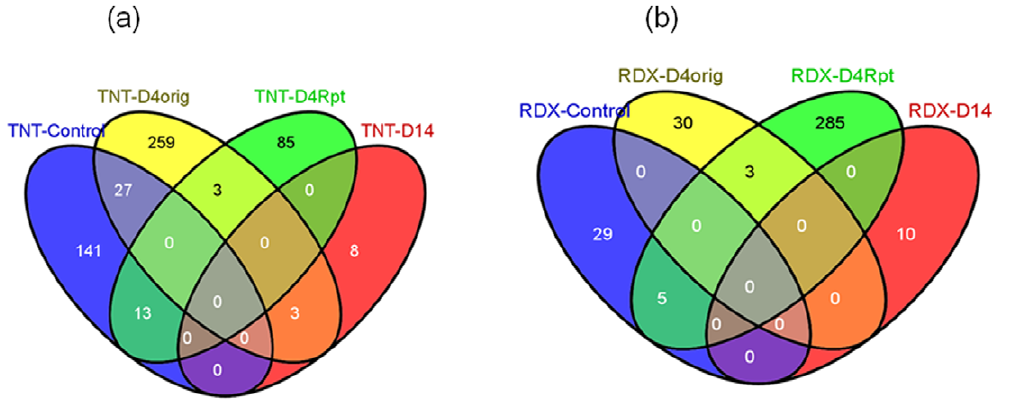
Figure 2. The number and overlapping of significant genes statistically inferred from class comparisons for (a) TNT and (b) RDX treatments. TNT/RDX-Control: two-class comparison between pooled controls and pooled TNT/RDX treatments; TNT/RDX-D4orig: multiple-class comparison of 4-day TNT/RDX treatments including the control group; TNT/RDX-D4Rpt: multiple-class comparison of 4-day repeat TNT/RDX treatments including the control group; TNT/RDX-D14: multiple-class comparison of 14-day TNT/RDX treatments including the control group (also see Materials and Methods ).